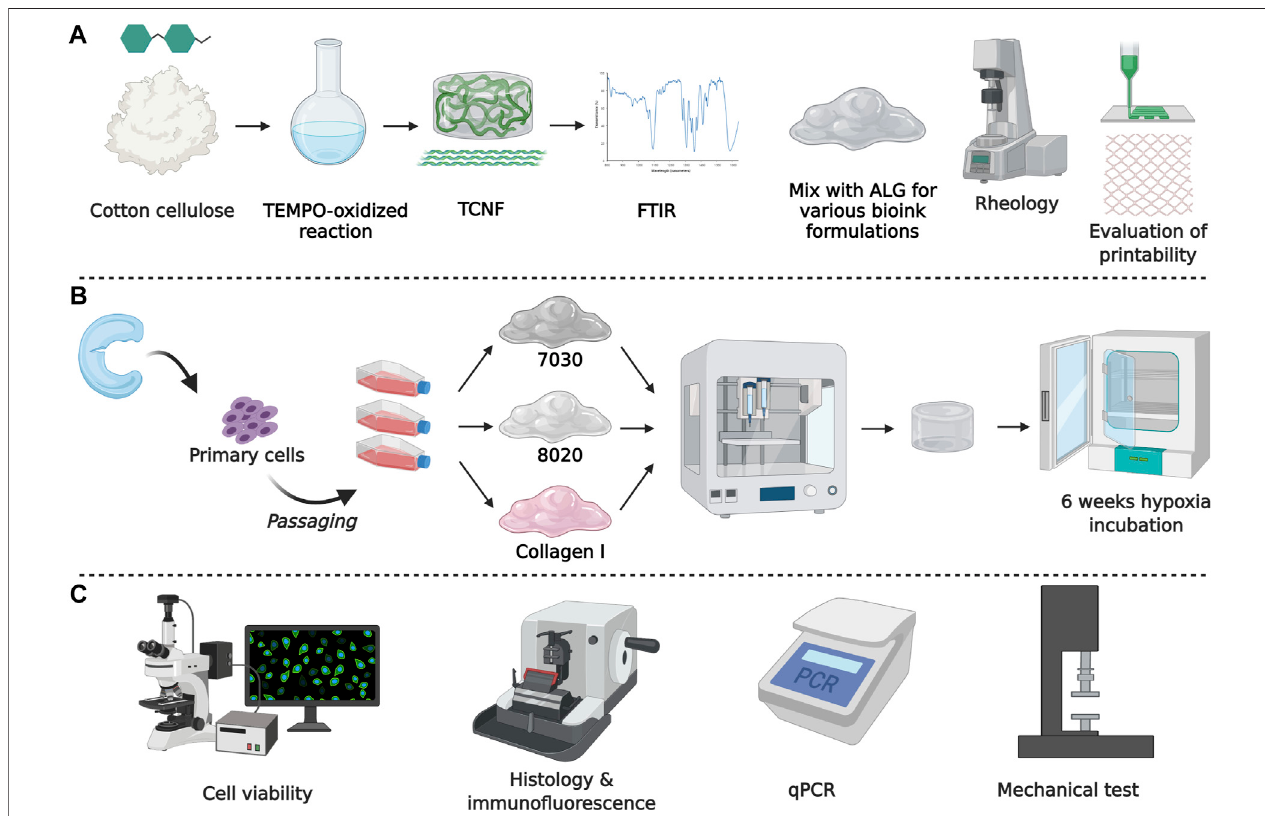
FIGURE 1 | Schematic diagram of the experimental design. (A) Biomaterial formation and characterization, (B) engineered tissue formation, and (C) evaluation of engineered tissues.